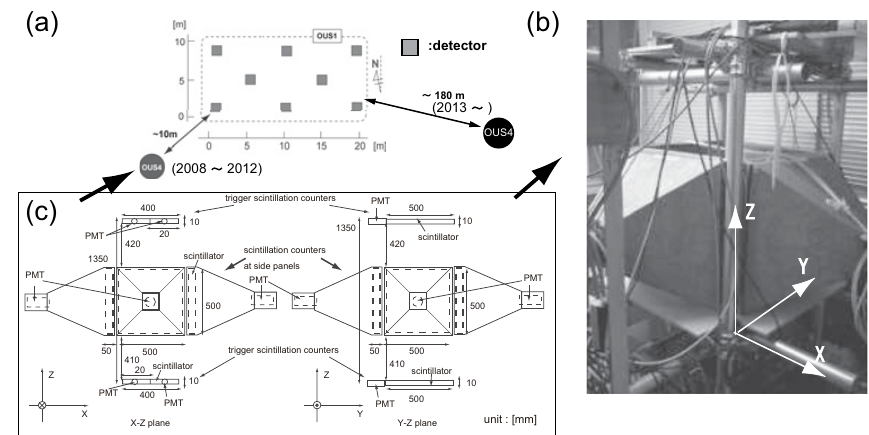
Figure 1. (a) The arrangement of OUS1 and OUS4. (b) Photograph of OUS4. (c) The schematic drawing of OUS4. with a PMT and a black plastic cover. The total area of each of the bottom and top counters is 0 . 2 m 2 respectively.